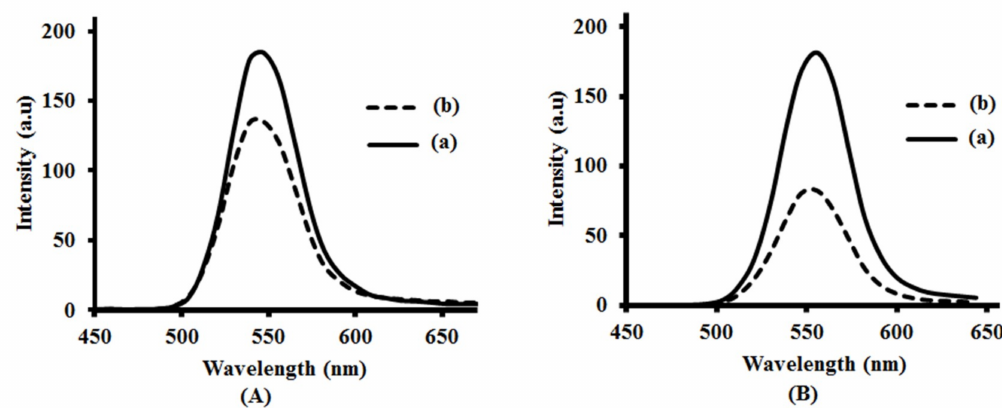
Figure 10. Photoluminescence spectra of CdSe(S) QDs ( A ) and CdSe(S)/ZnO QDs ( B ): ( a ) in water and ( b ) in cell media. The excitation wavelength of the instrument was adjusted at 405 nm at the time of measuring the photoluminescence